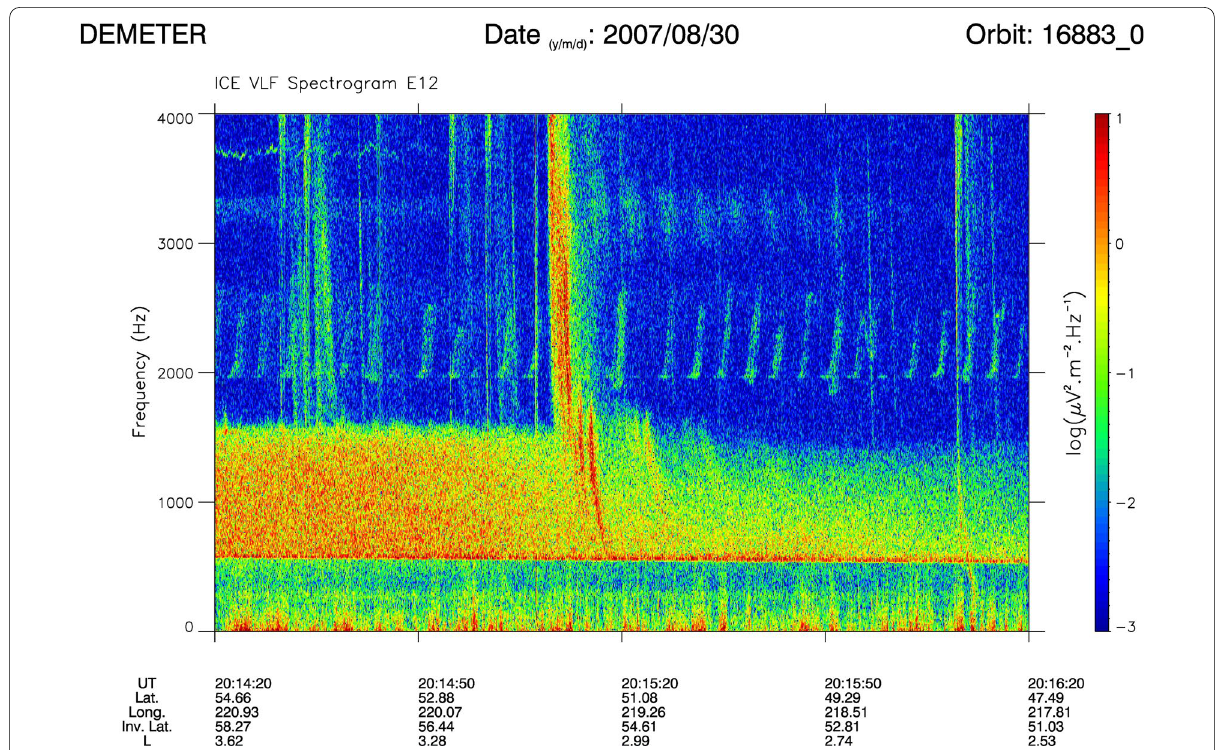
Fig. 5 Spectrogram of an electric component recorded onboard DEMETER in the Northern hemisphere between 20:14:20 and 20:16:20 UT (see Fig. 7), and in the frequency range 0–4 kHz. The power spectral density is color-coded according to the scale on the right. The parameters below the panels indicate the UT, the geographical latitude and longitude, the invariant latitude, and the McIlwain parameter